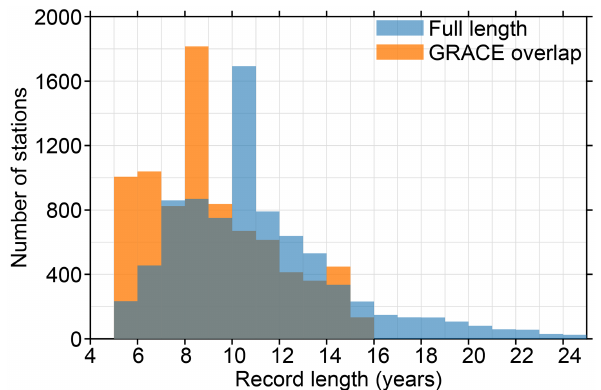
Figure 4. Overview of the GRACE mascon geometry and mascons associated with Greenland Ice Sheet (GrIS), Antarctic Ice Sheet (AIS), glaciers, and TWS mass changes. The light-colored mascons denote mascons which partially cover oceans and use the CRI filter. Mass changes in purple mascons (glaciers full) are fully attributed to glaciers, while turquoise mascons (glaciers split) are separated into a glacier and TWS term; see text for details.